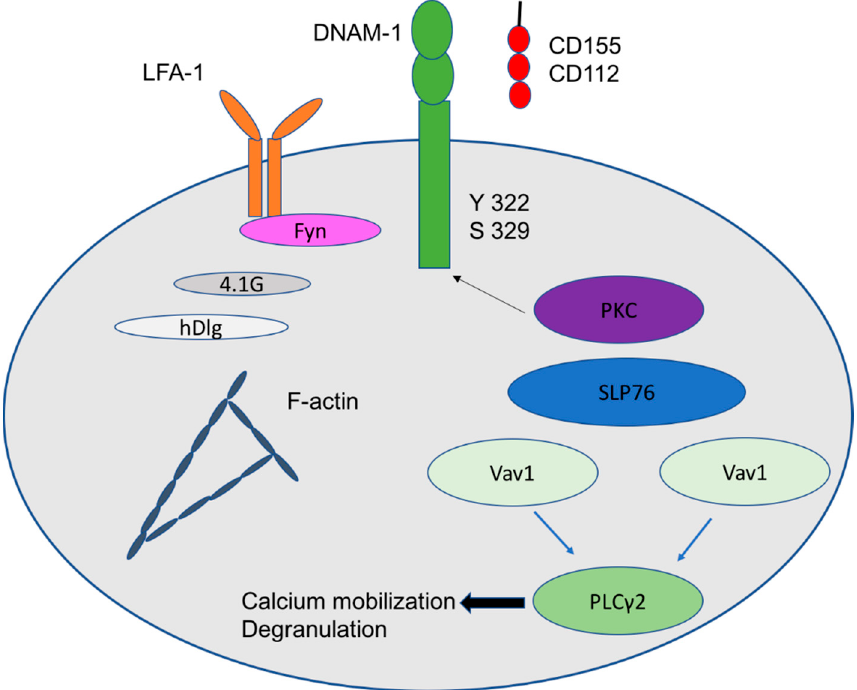
Figure 1. Signaling pathway of DNAM-1 receptor.